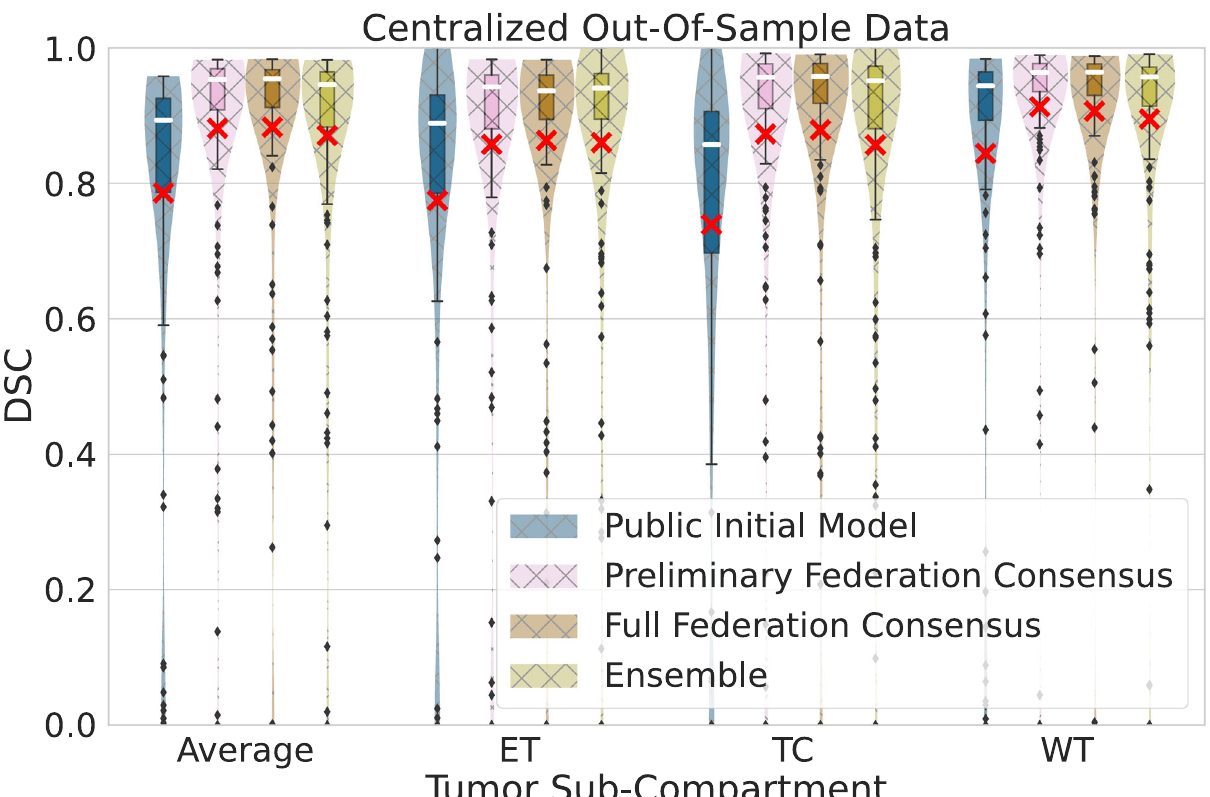
Fig. 2 | Generalizable Dice similarity coef fi cient (DSC) evaluation on ‘ cen- tralized ’ out-of-sample data ( n =154 biologically independent cases), per tumor sub-compartment (ET enhancing tumor, TC tumor core, WT whole tumor) and averaged across cases. Comparative performance evaluation across the public initial model, the preliminary consensus model, the fi nal consensus model, and an ensemble of single site models from collaborators holding>200 cases.Notetheboxandwhiskersinsideeachviolinplot,representthetrueminand max values. The top and bottom of each “ box ” depict the 3rd and 1st quartile of